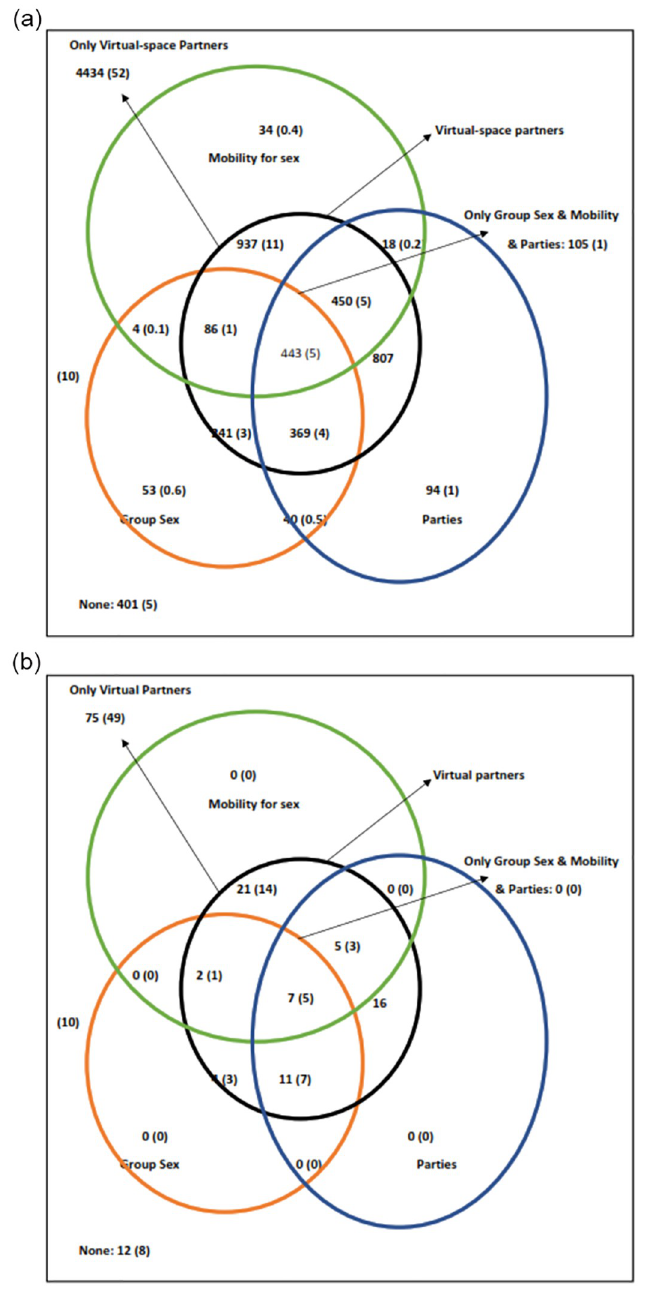
Fig 4. a. Venn diagram showing the distribution and overlap of various behaviours (partners from virtual space, group sex, mobility for sex, attend parties) in HIV negative men who have sex with men, Mumbai, India. b. Venn diagram showing the distribution and overlap of various behaviours (partners from virtual space, group sex, mobility for sex, attend parties) in HIV infected men who have sex with men, Mumbai, India. among the group of MSM who had partners from physical space, HIV negative MSM were sig- nificantly more likely to have any of these three risk behaviours (group sex, parties, and mobil- ity for sex) compared with HIV positive MSM (47.2% vs 0%, p = 0.001). We also found that the proportion of any of these three risk behaviours (group sex, parties, and mobility for sex)